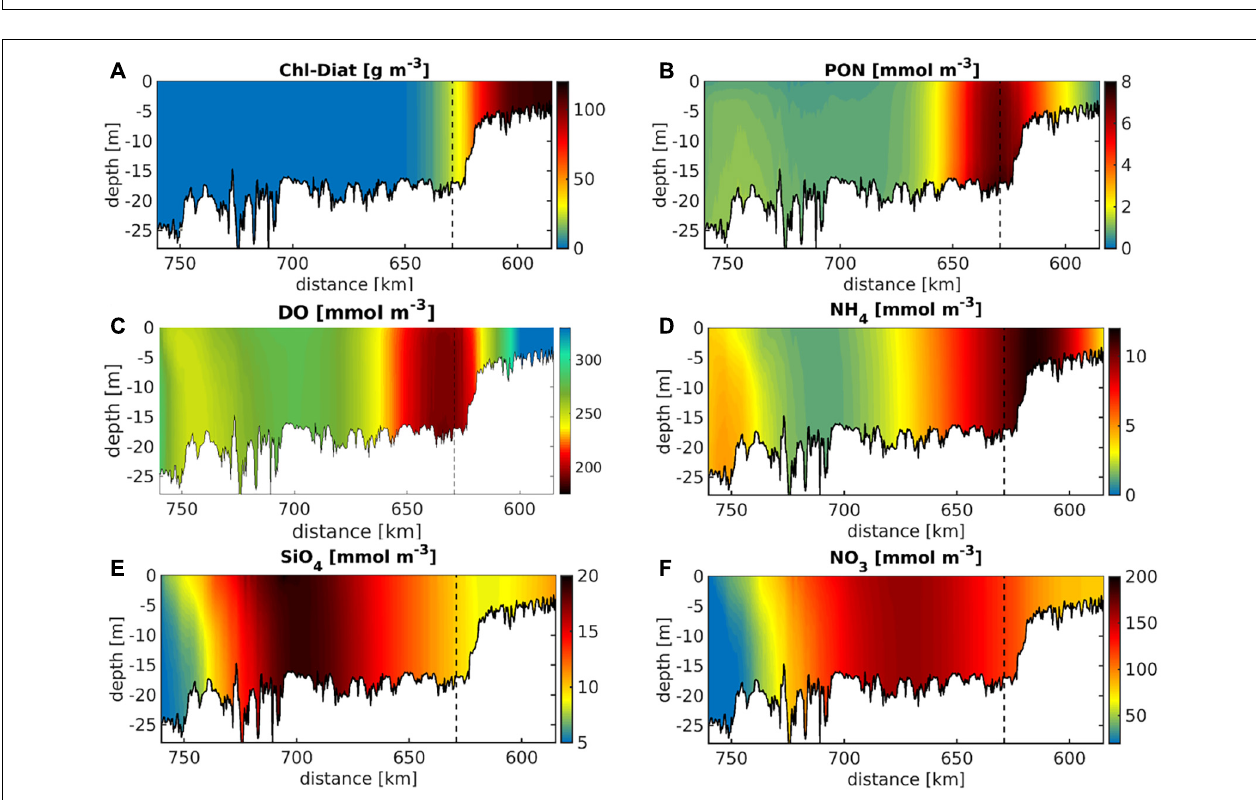
FIGURE 8 | Time-averaged vertical anomalies of (A) chlorophyll, (B) detritus, (C) dissolved oxygen, (D) ammonium, (E) silicate, and (F) nitrate concentrations are given for the main channel between km 610 and km 640 of the Elbe estuary. The time averages represent the simulation during the period of May to September 2012. Note different colour bar in (C) with warm colours representing low oxygen levels.